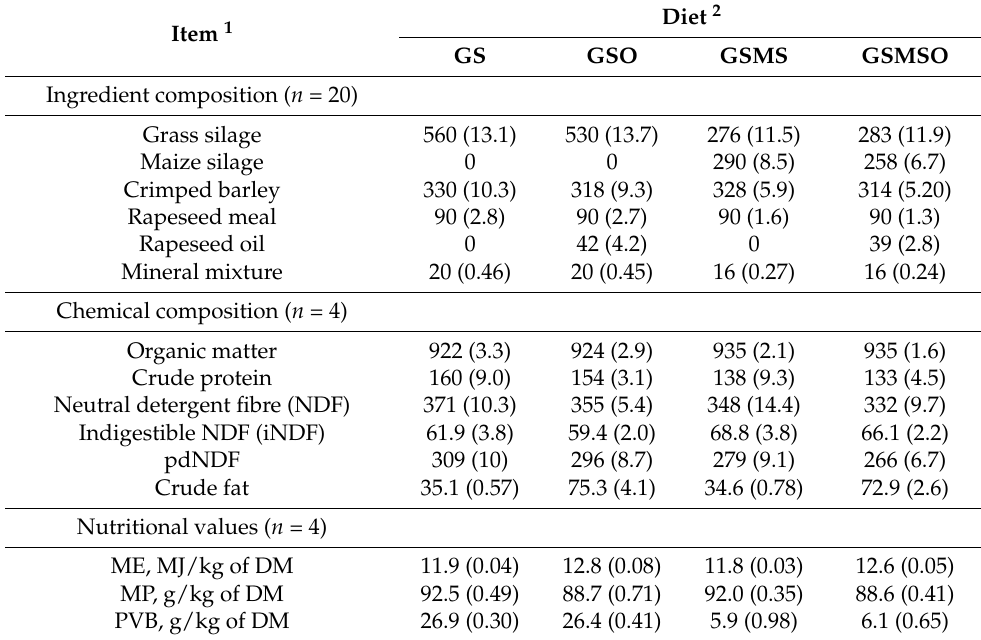
Table 2. Ingredient and chemical composition, and nutritional values of experimental diets fed to dairy cows (g/kg of DM); mean ±